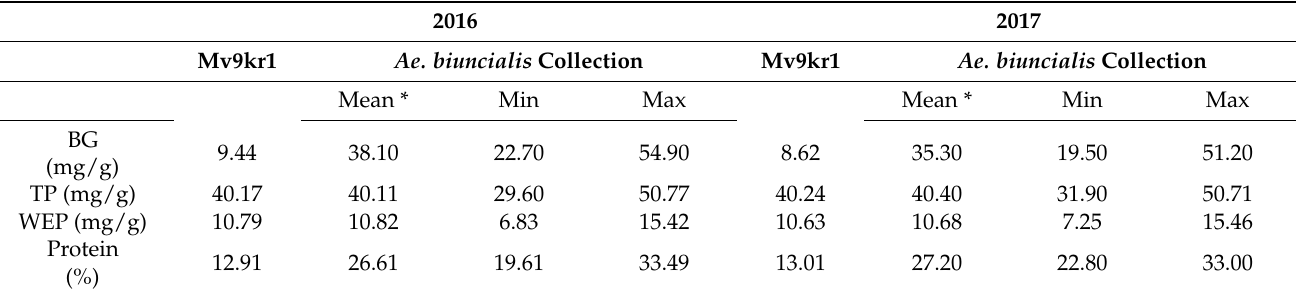
Table 1. The content of β -glucan (BG), total- (TP) and water-extractable pentosans (WEP), and protein content in grains of Ae. biuncialis collection and Mv9kr1 wheat line grown in Martonv á s á r in 2016 and